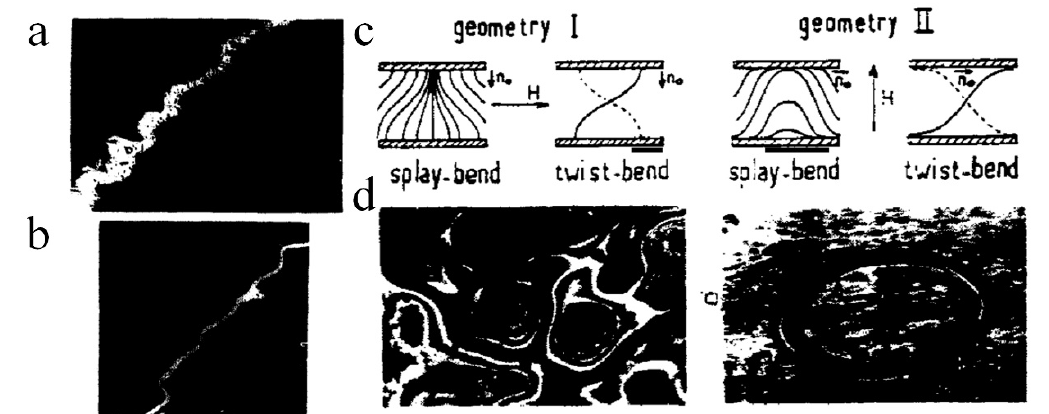
Figure 2. Typical image of the free surface of a MBBA droplet within which a twist wall was generated at ( a ) H = 3000 G and ( b ) H = 6000 G, where H represents the magnitude of the magnetic field. Reprinted with permission from Ref. [17]. Copyright 1972 Elsevier. ( c ) Schematic distortion of the director structure of different walls. ( d ) The microscopy of the walls corresponding to ( c ). Reprinted with permission from Ref. [19]. Copyright 1972 Elsevier.